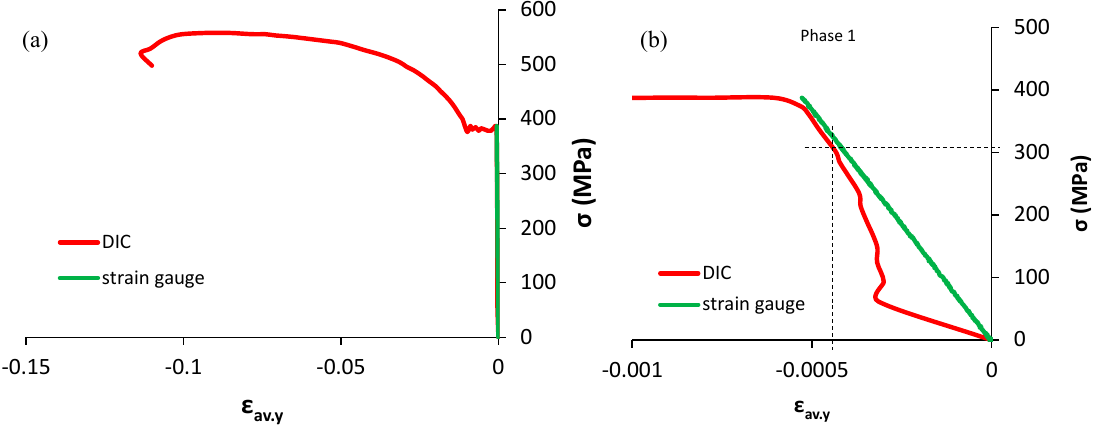
Figure 4. ( a ) The curve of the stress ( σ ) versus the transversal average strain ( ε av.y ), and ( b ) the enlargement of ( a ) within Phase 1 (elastic region). The ε av.y was measured using DIC (over the AB line) and a strain gauge.